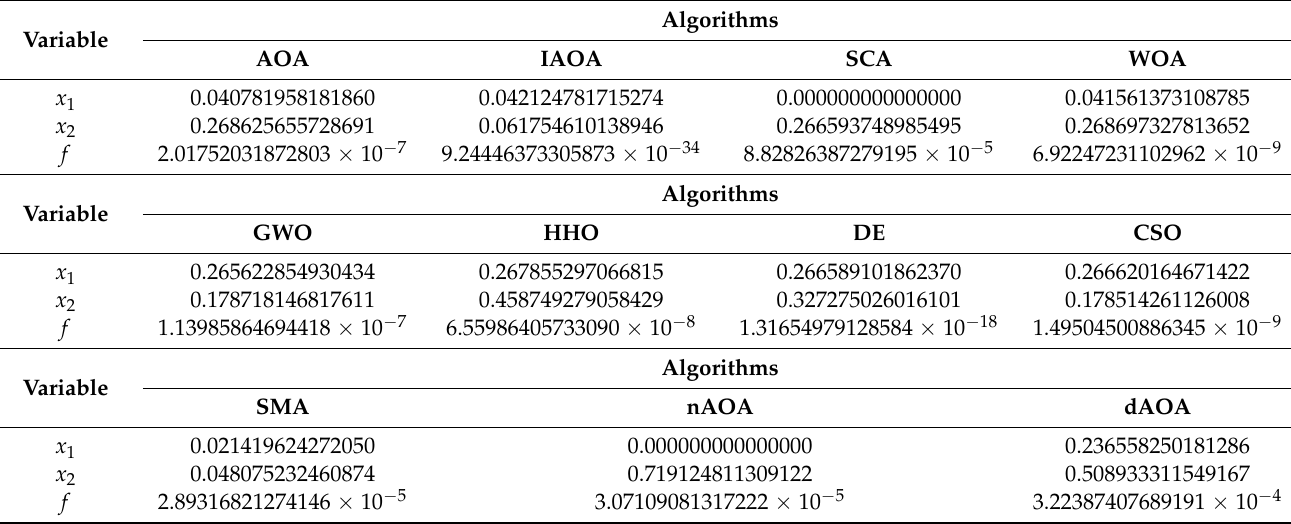
Table 2. Comparison of the experimental results for